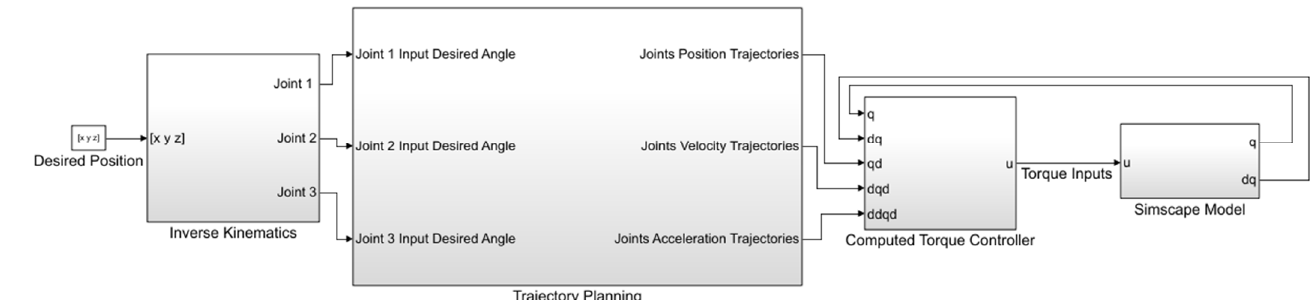
Figure 14. The complete dynamic model of SAMA in addition to the PID-CTC model.